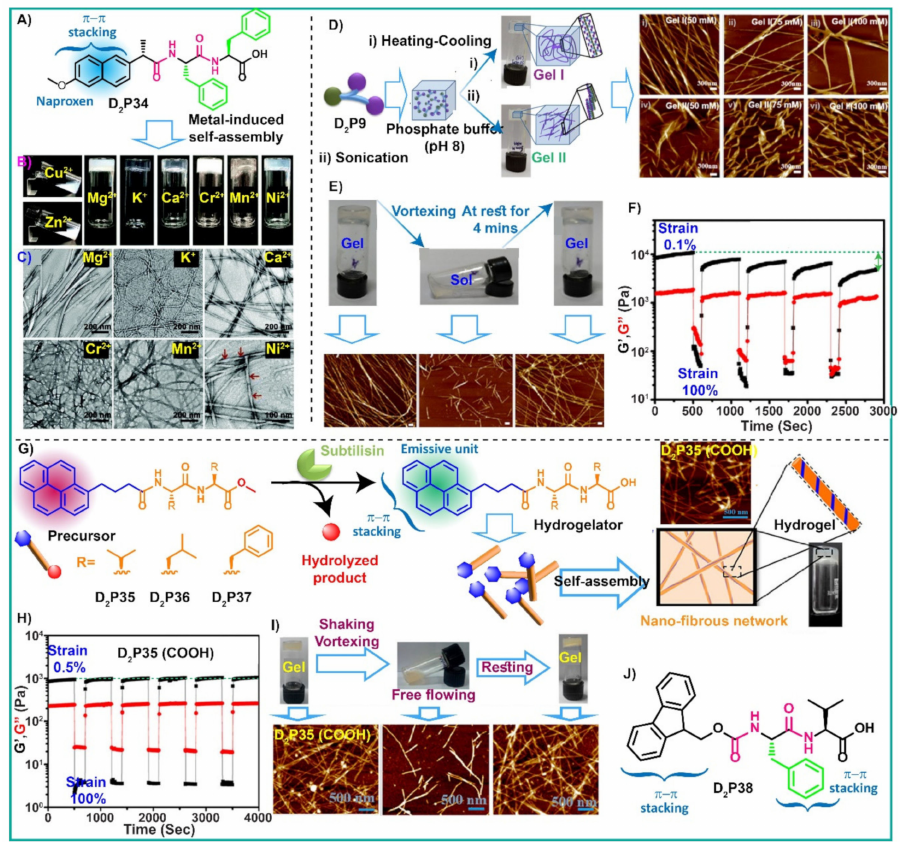
Figure 6. ( A ) Chemical structure of the dipeptide hydrogelator (D2P34). ( B ) Metal-induced self- assembly and hydrogel formation. ( C ) TEM images of the respective metallogel; reproduced with permission from Ref. [85] Copyright (2020) Royal Society of Chemistry. ( D ) Schematic illustration of gel formation and the AFM images of the resultant gels. ( E ) Self-healing behavior of the hydrogel with the representative AFM images. ( F ) Rheology experiment confirming the thixotropic behavior of the hydrogels; reproduced with permission from Ref. [77]. Copyright (2020) American Chemical Society. ( G ) Molecular structures of the hydrogelators, representative self-assembly process followed by gel formation with AFM image. ( H ) Step-strain rheological analysis for thixotropicity. ( I ) Self-healing ability of the gel with demonstrative AFM images. Reproduced with permission from Ref. [86] Copyright (2021) American Chemical Society. ( J ) Chemical structure of the dipeptide hydrogelator; redrawn from Ref. [87]. Copyright is not applicable